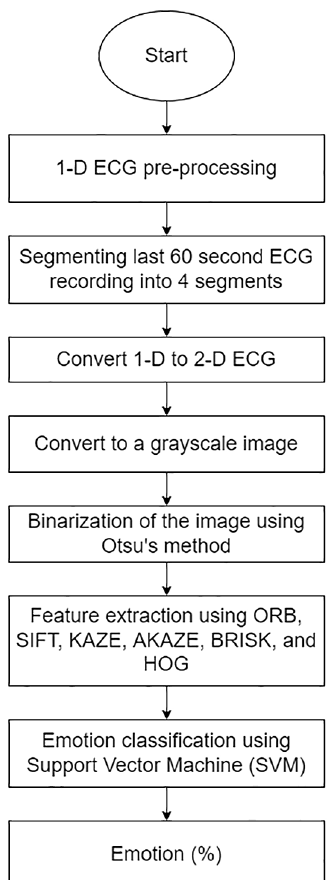
Figure 5. The overall structure of 1-D ECG-based ERS.